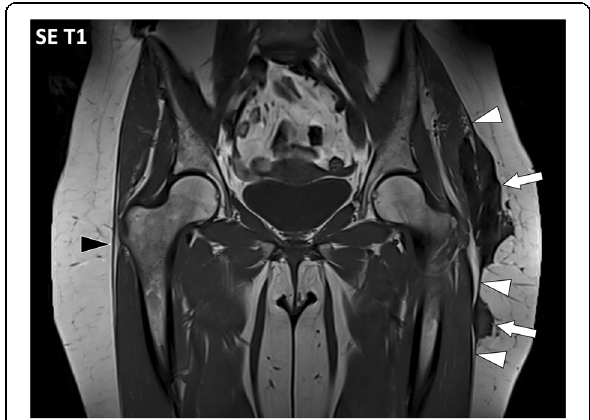
Fig. 14 Coronal SE T1w image of the pelvis of a 52-year-old female with a desmoid tumor in the left hip area. MRI demonstrates low signal intensity masses (arrows) in continuity with the iliotibial tract and the deep peripheral fascia with typical aspect described as “ fascia tail sign ” (white arrowheads). The right iliotibial tract and deep peripheral fasciae are normal (black